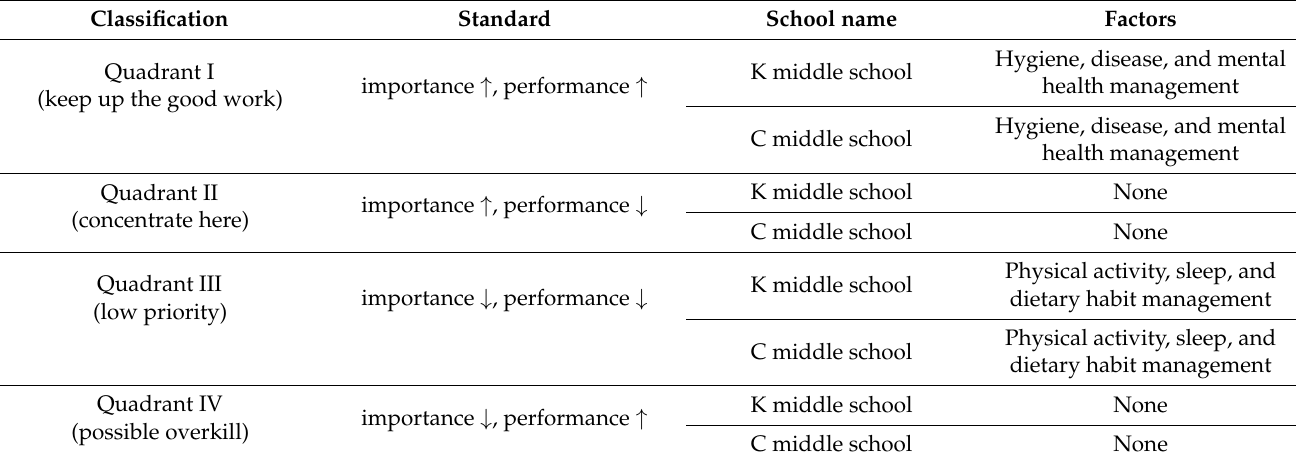
Table 5. Distribution of health awareness factors in the K and C middle school